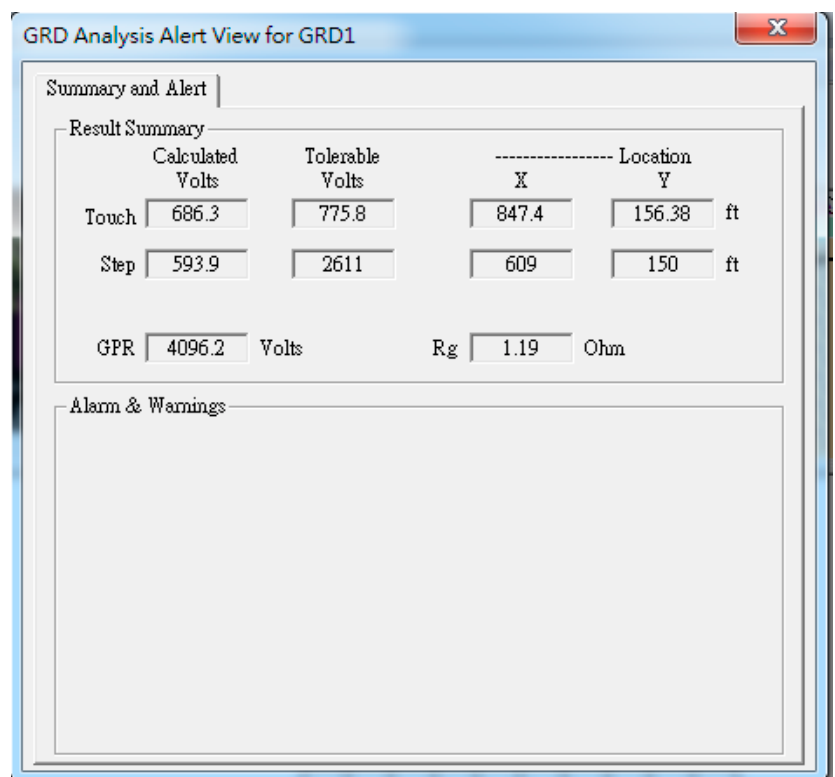
Figure 11. FEM simulation results with the best ground grid parameters predicted by the RBF neural network.